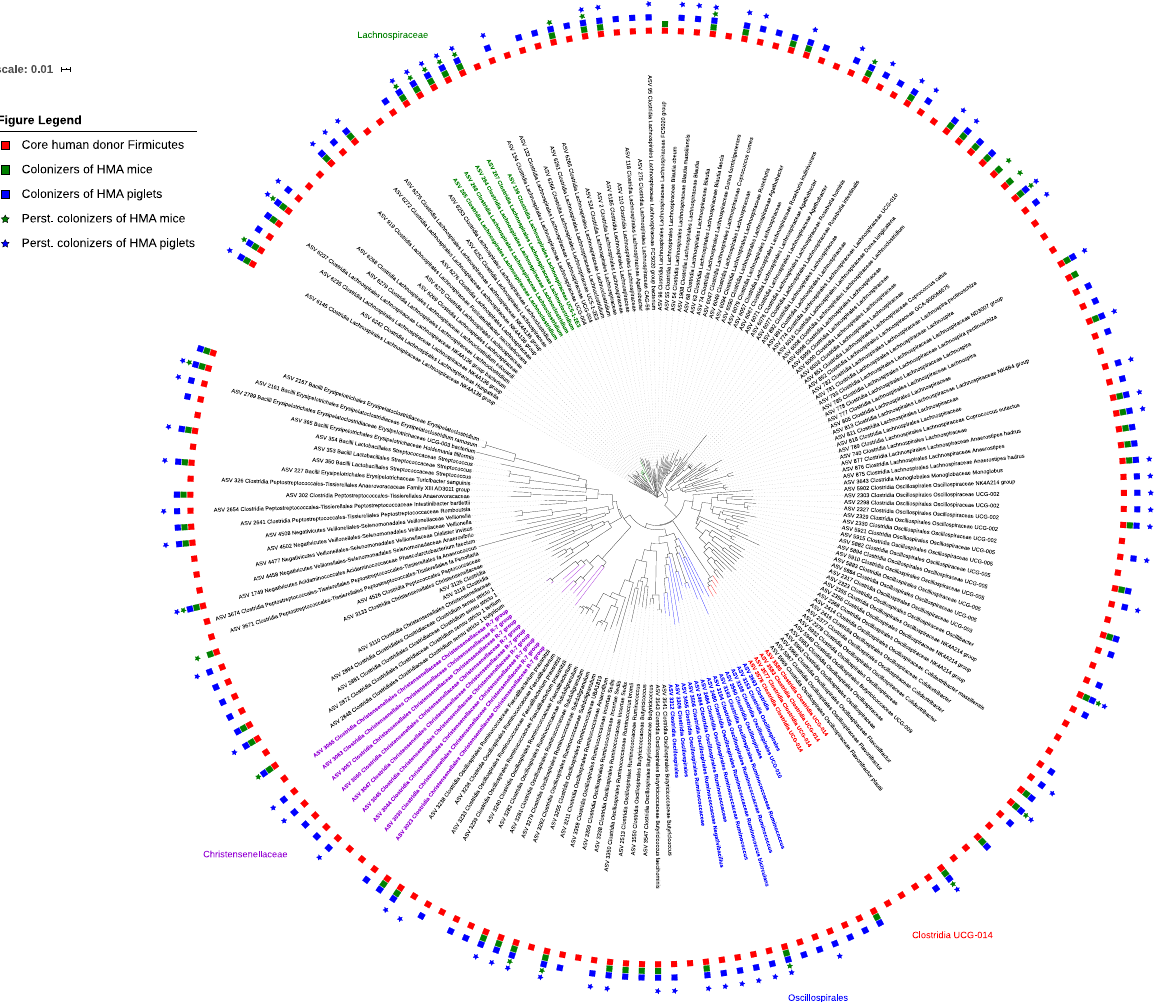
Fig. 6 Phylogenetic tree depicting the overall distribution of core donor ASVs classi fi ed as Firmicutes among the two HMA animal models. Red squares indicate the presence of core Firmicutes ASVs in the human donors while the green squares and blue squares indicate which of those Firmicutes ASVs were able to colonize the HMA mice and piglets, respectively. Green stars indicate persistent colonizers of HMA mice and blue stars indicate persistent colonizers of HMA piglets. n = 13 (3 piglets/donor, with the exception n = 4 for Donor_1, 2 days post inoculation) and n = 37 mice (Donor_1 = 7, Donor_2 = 10, Donor_3 = 10, Donor_4 = 10).